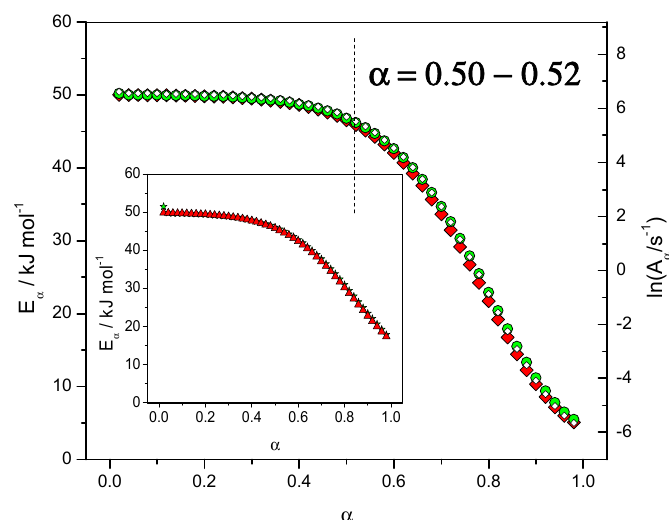
Figure 13. Dependence of the effective activation energy ( E α ) and pre-exponential factor (ln A α ) with the extent of conversion ( α ). Non-isothermal data. Open lozenges: pre-exponential factor computed using compensation parameters method, red lozenges: E α computed with FR method, green circles: E α computed with NLN method. Inset: isothermal data. Red triangles: E α computed with FR method, green stars: E α computed with NLN method.